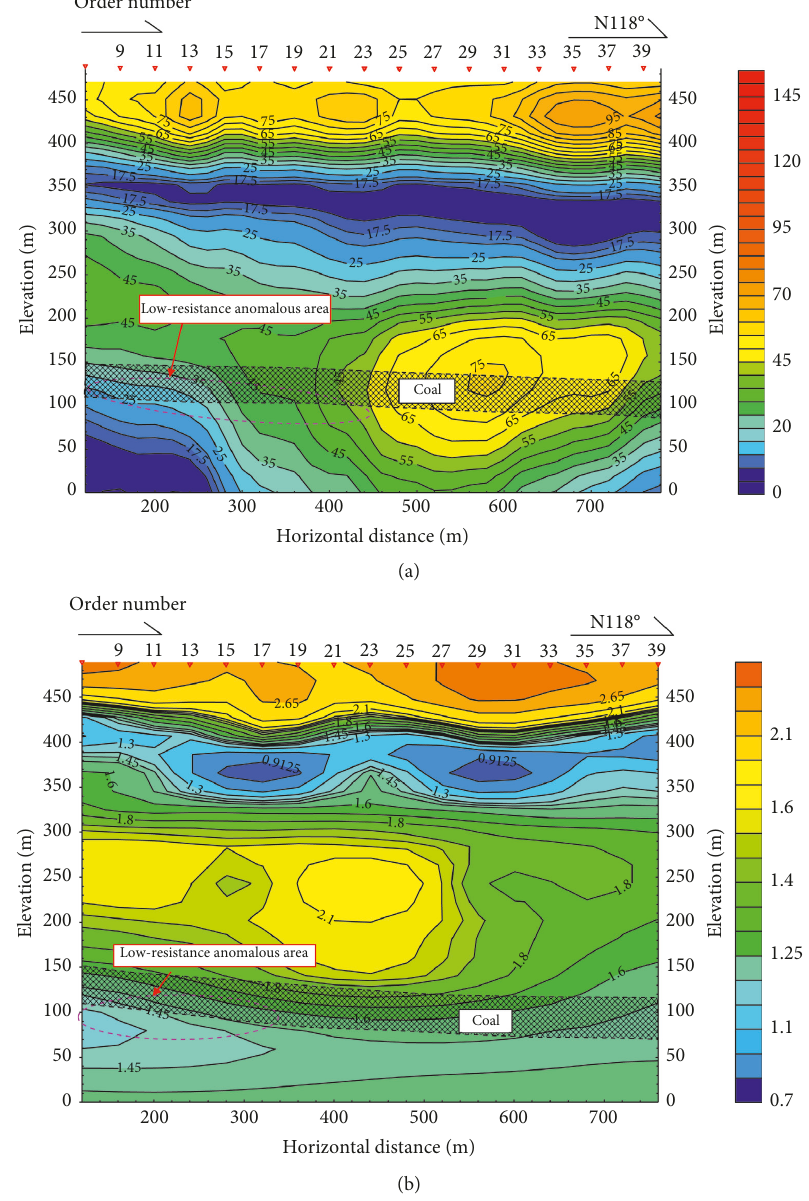
Figure 15: Resistivity sections obtained by different methods. (a) Inversion of the resistivity profile from line 33 of the TEM method. (b) Inversion of the resistivity profile from line 33 of the CSAMT